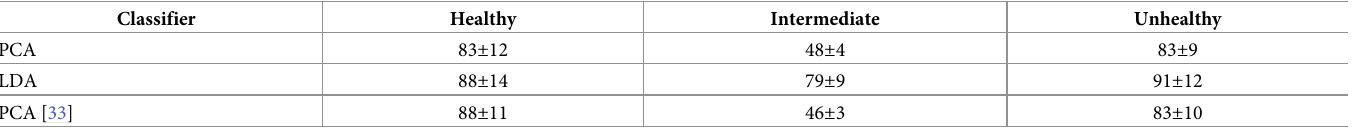
Table 1. Classification efficiency (in percentage of correctly classified) for different classifiers (column headers) used to distinguish images of Meibomian glands. 95% Confidence Interval (see S7 Appendix for details).